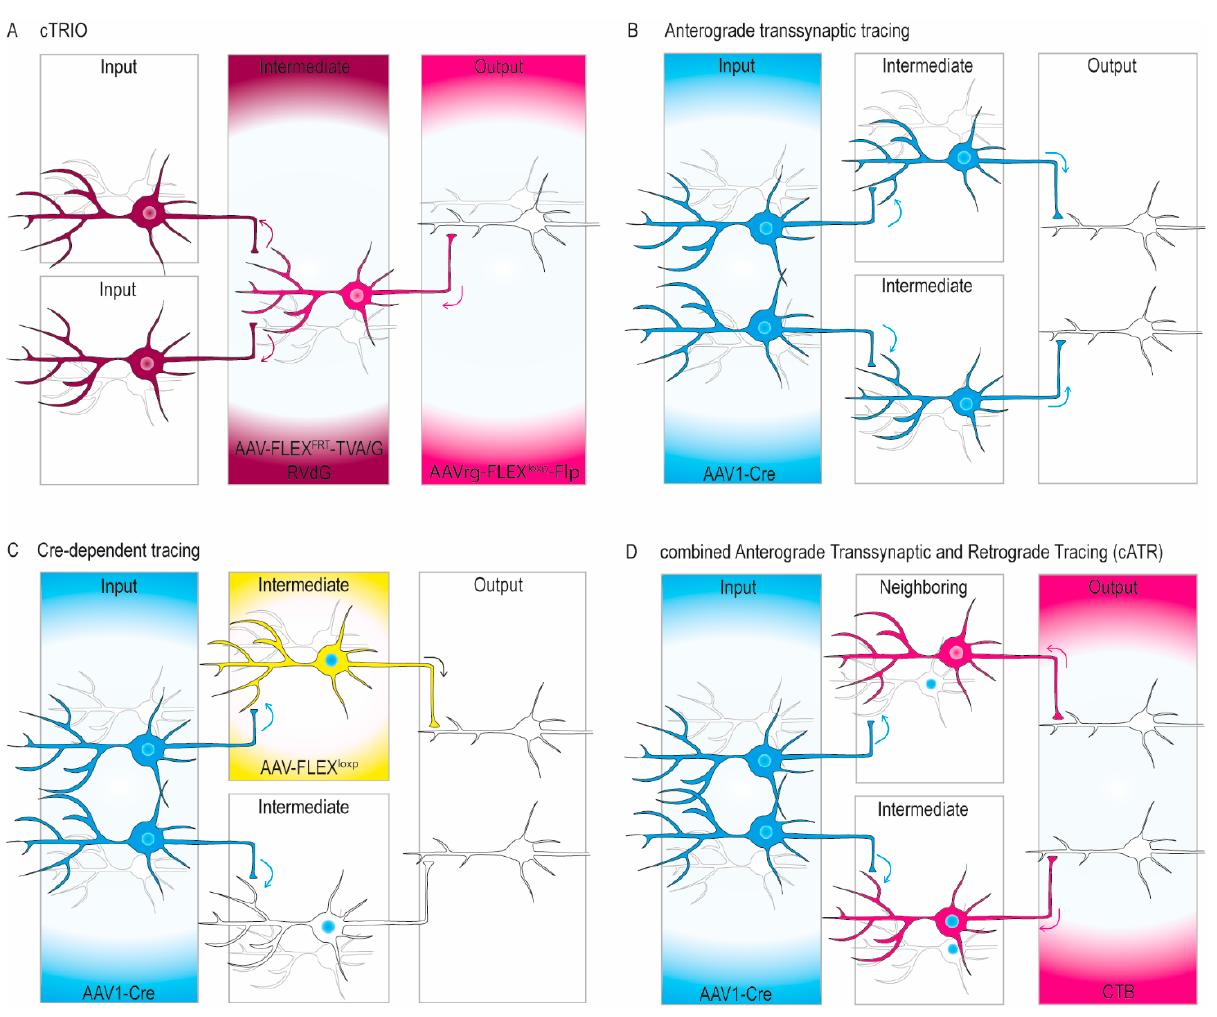
Figure 1. Schematic representations of concepts of currently available disynaptic tracing approaches and cATR. ( A ) Cell-type specific Tracing of the Relationship between Input and Output (cTRIO). In this method a Flp-dependent helper virus (AAV-FLEX FRT -TVA/G) and the RVdG are injected in the intermediate and a retrograde Cre-dependent virus expressing Flp (AAVrg-FLEX loxp -Flp) in the output area of a Cre-expressing reporter line to facilitate cell-type specificity. Arrows indicate the direction of tracer transport or synaptic jump. This approach allows for the identification of the cells that project to neurons located in the intermediate region targeting the output area, but it does not allow for specific double labeling of the intermediary neurons that connect the input and output areas. Therefore, it is difficult to determine unequivocally which of the labeled intermediary neurons is actually responsible for the retrograde labeling in the input region. Moreover, as the helper virus has to be injected in a particular intermediary of interest, one can only screen for one intermediary at a time, preventing a widespread, let alone whole-brain, screening of such areas. ( B ) Anterograde transsynaptic tracing using an anterograde transsynaptic virus expressing Cre (AAV1-Cre) in the input area in a reporter line, visualizing monosynaptic target cells and their axons; disynaptic projections from injection location, not restricted to one output region. This method does also not allow for the identification of individual intermediary neurons based on a specific output region with double labeling; hence the precise intermediate neuron through which labeling in the output region is observed cannot be unequivocally determined. ( C ) Cre-dependent tracing using an anterograde transsynaptic virus expressing Cre (AAV1-Cre) in the input area, and a Cre-dependent (AAV-FLEX loxp ) anterograde tracer in a proposed intermediary neuron, similar to ( B ) but more specific. This method does allow for the identification of individual intermediary neurons with double labeling, but here too one cannot be sure that that particular individual neuron gives rise to the anterograde labeling in the target regions as it may concern a local interneuron that did take up Cre, but in fact did not project to the target region. Additionally, alternative intermediates cannot be investigated using this approach. ( D ) Concept of novel approach for disynaptic tracing to identify